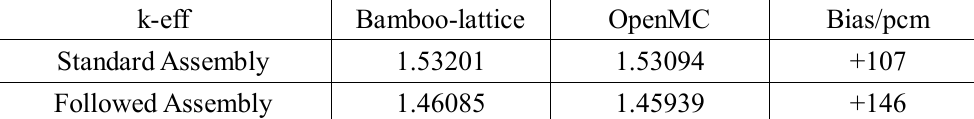
Table III. Comparison of k-eff of fuel assemblies with burnup